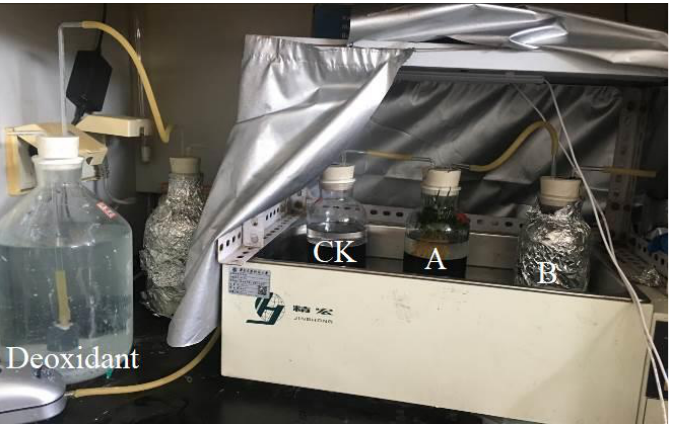
Figure 1. System for measuring radial oxygen loss measurement.